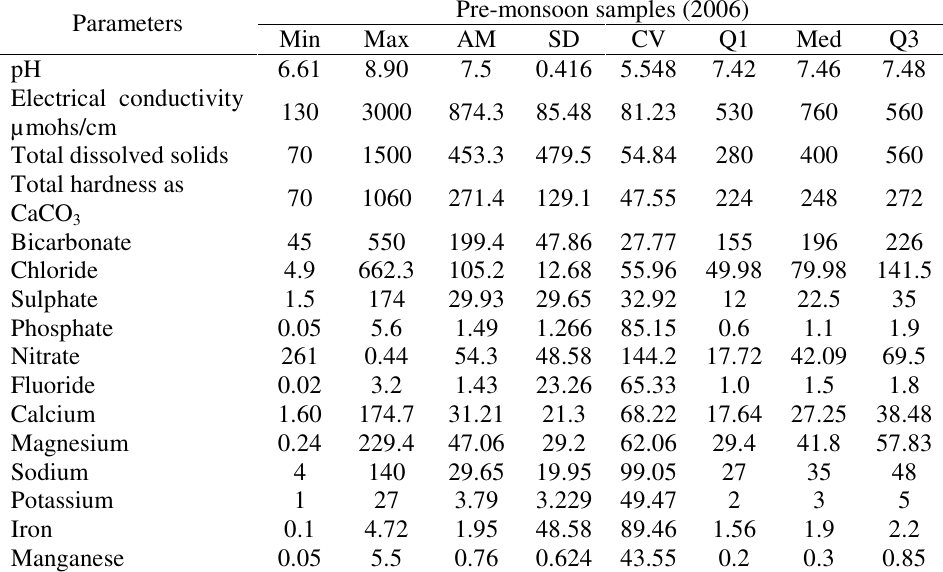
Table 2. Normal statistics of water quality parameters of groundwater